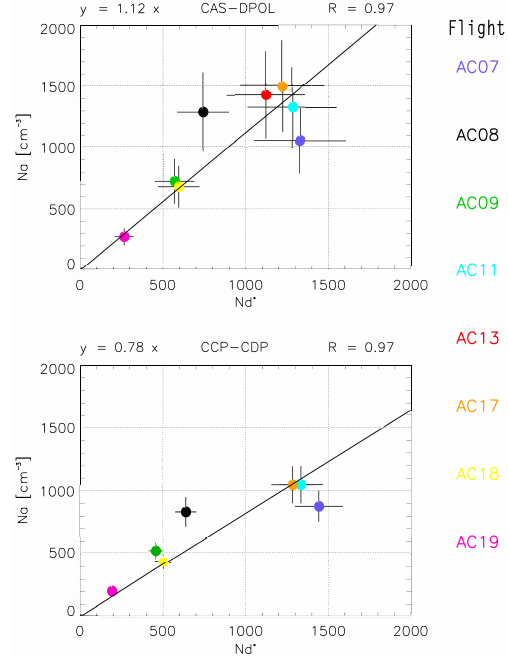
Figure 15. N ∗ vs. N a measured with CAS-DPOL and CCP-CDP d (indicated on the top of the panels) for profile flights during the ACRIDICON–CHUVA campaign. The color of the dots is associ- ated with the flight number shown at the right side of the panels. The error bars indicate the uncertainties in variable estimates. The linear regression equation and the correlation coefficient R are shown at the top of each